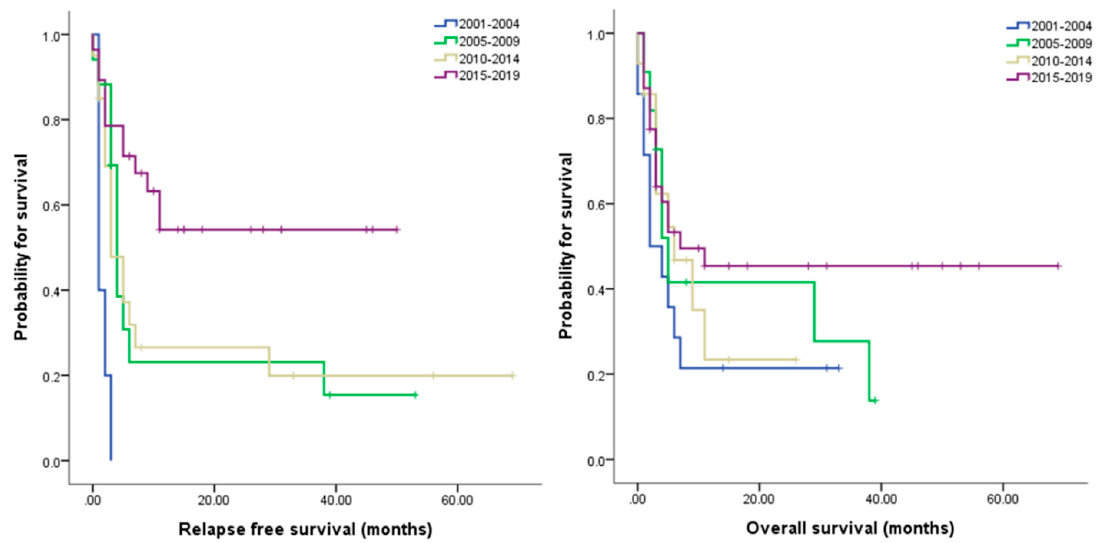
Figure 4. Relapse free survival ( left ) and overall survival ( right ) over time.